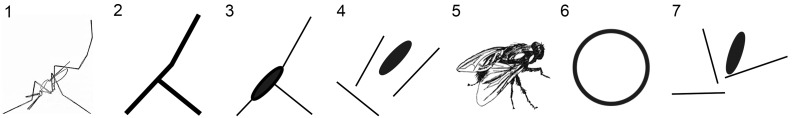
Images (and numbering as referred to in text) used as stimuli in both experiments.Images 1–4 are based on Anopheles mosquitoes. 1 is based on [60]. Image 4 is a disarranged version of image 3. Image 8 is a disarranged version of image 6. Image 7 is based on image 4 where the angles of the various elements have been altered.